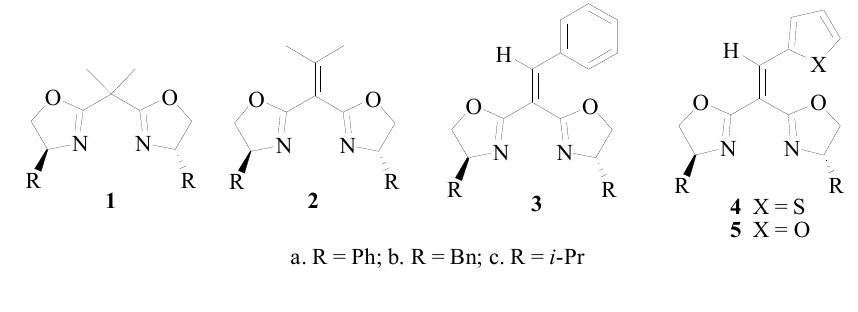
Figure 1. The alkylidene and arylidene malonate-type bis(oxazoline)